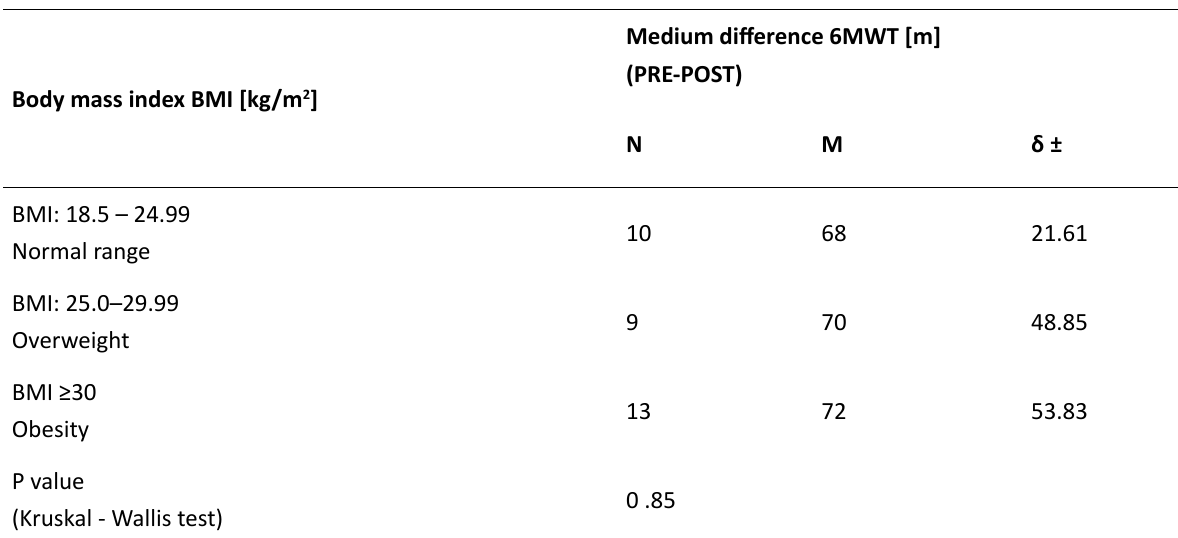
Table 3. 6MWT results before and after rehabilitation depending on the BMI value